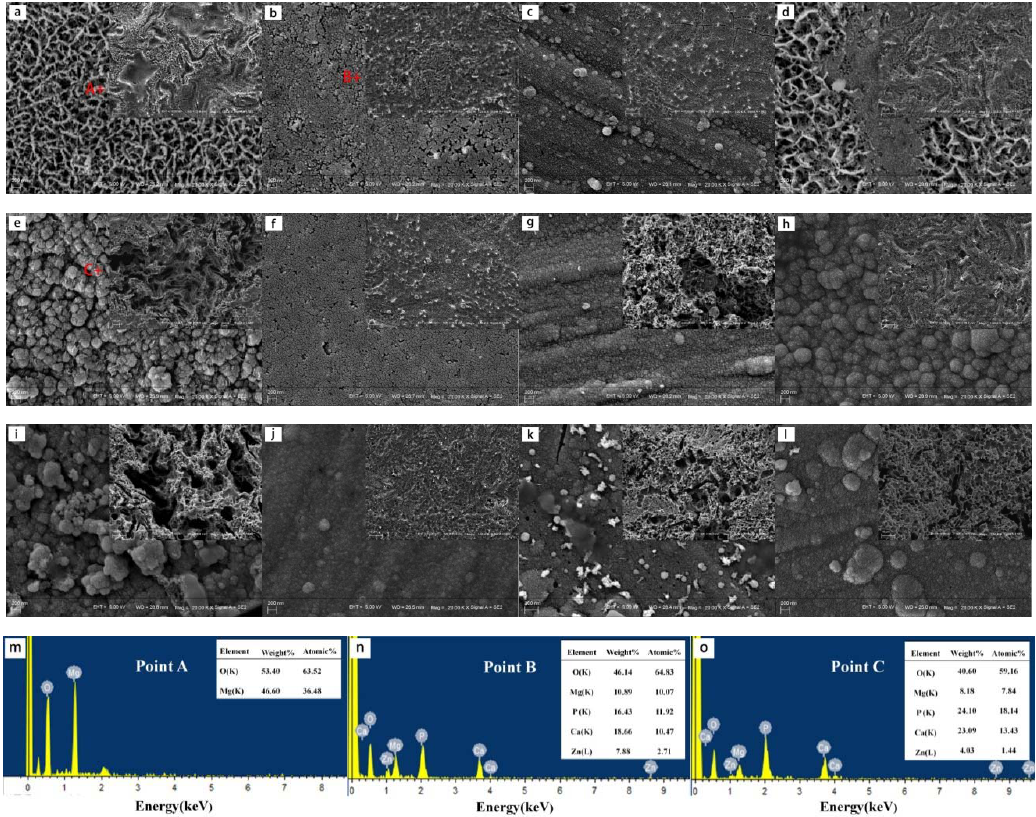
Figure 6. The SEM images of corrosion morphology of ZX30 ( a , e , i ), ZK30 ( b , f , j ), ZKJ300 ( c , g , k ), ZKXQ3000 ( d , h , l ) alloys immersing for 1 d ( a – d ), 5 d ( e – f ) and 15 d ( i – l ) and EDS images of point A ( m ), point B ( n ), point C ( o ). The SEM images of corrosion morphology of ZX30, ZK30, ZKJ300 and ZKXQ3000 alloys after removing the corrosion products are on the upper right corner of figure ( a – l ).